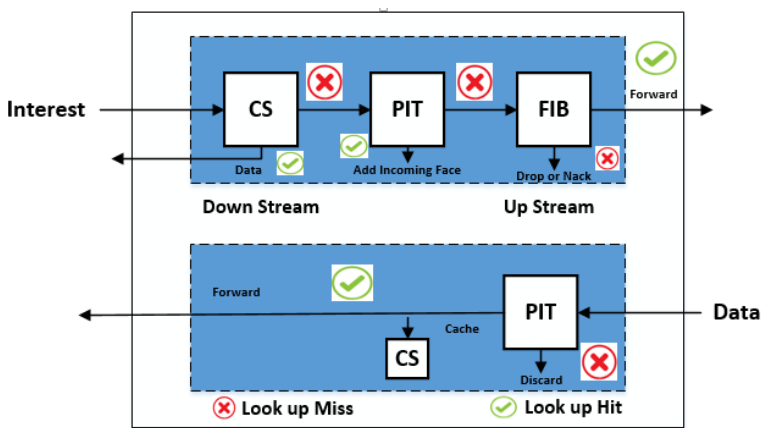
Figure 2. Two Way Packet Flow Communication in